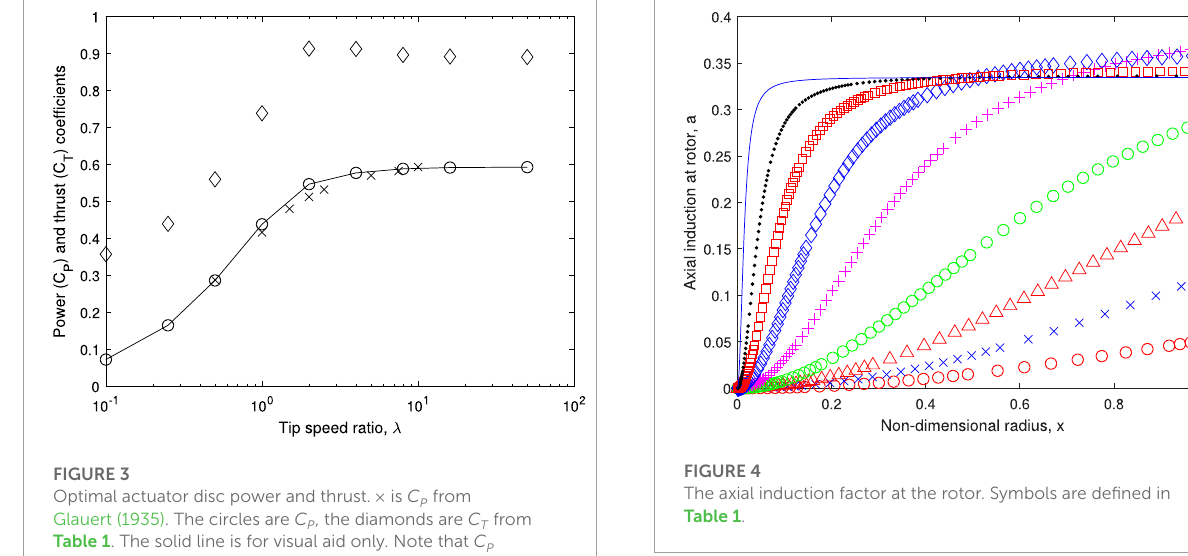
FIGURE 4 The axial induction factor at the rotor. Symbols are defined in Table 1 . is the value in Table 1 . C varied more, from 0.8847 to 0.9132 for T the same increase in R . The peak region for C was flat at all λ . ∞ P